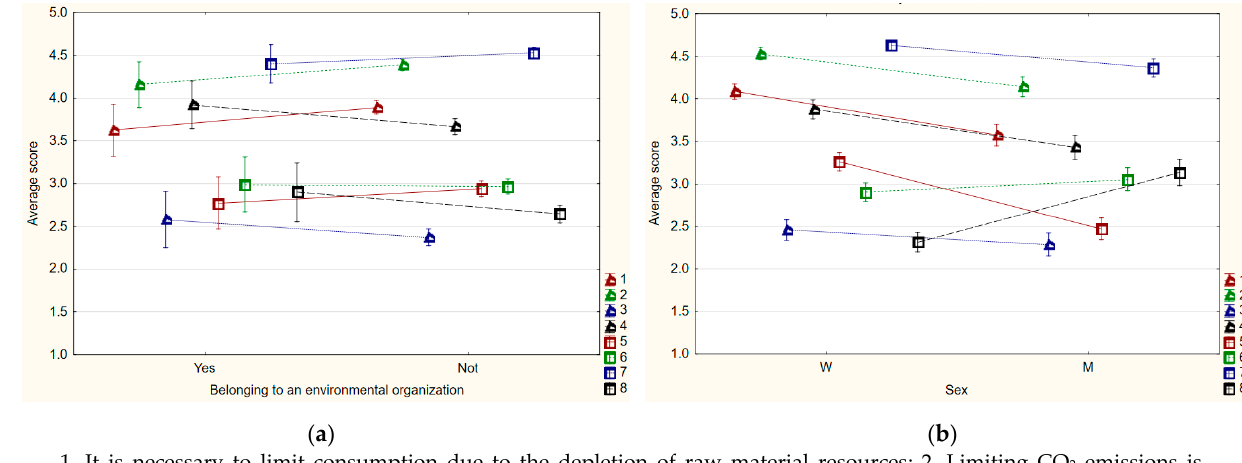
Figure 8. Average ratings of theses diagnosing the ecological attitude and the perception of the energy sector categorized due to ( a ) membership in pro-ecological organizations; ( b ) sex of respondents.